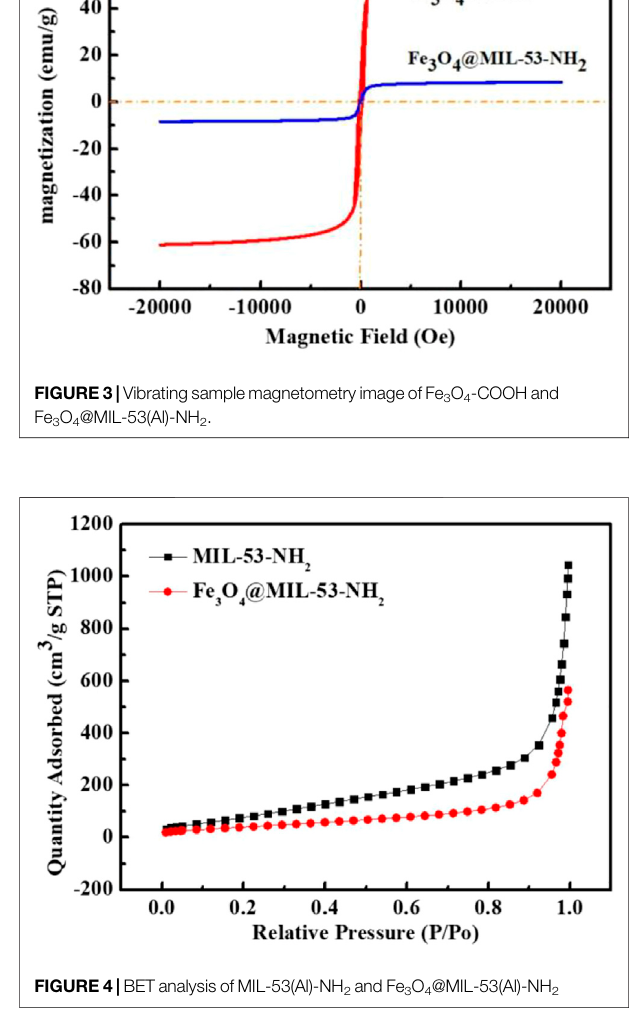
Frontiers in Chemistry |